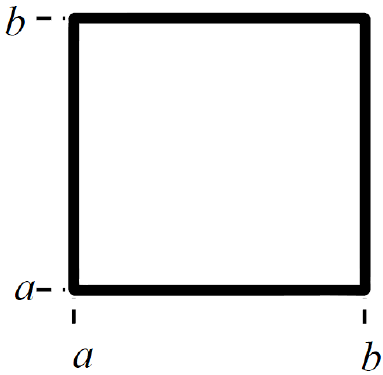
Figure 1. Top view of Representative Volume Element (RVE).